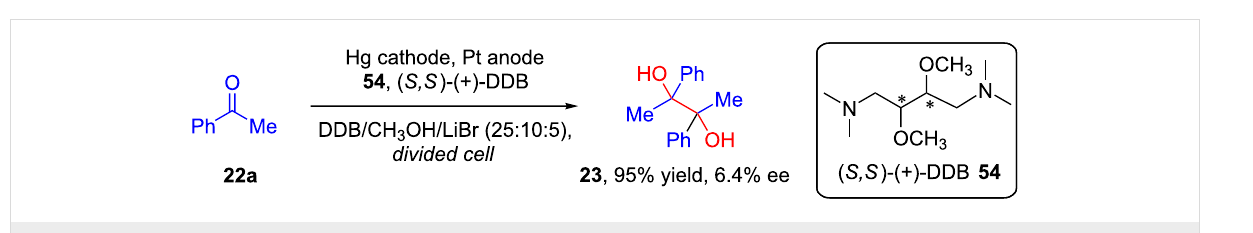
Scheme 21: Asymmetric electrochemical pinacolization in a chiral